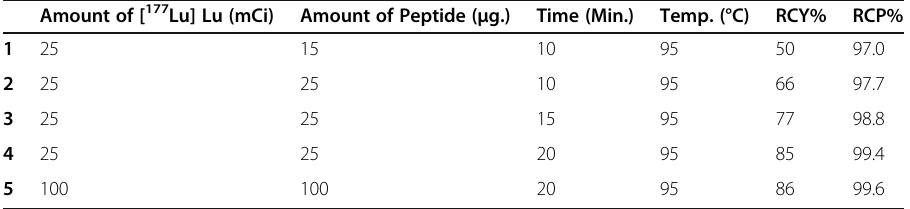
Table 2 Preliminary studies of [ 177 Lu]Lu-FAPI-46 Amount of [ 177 Lu] Lu (mCi) Amount of Peptide ( μ g.) Time